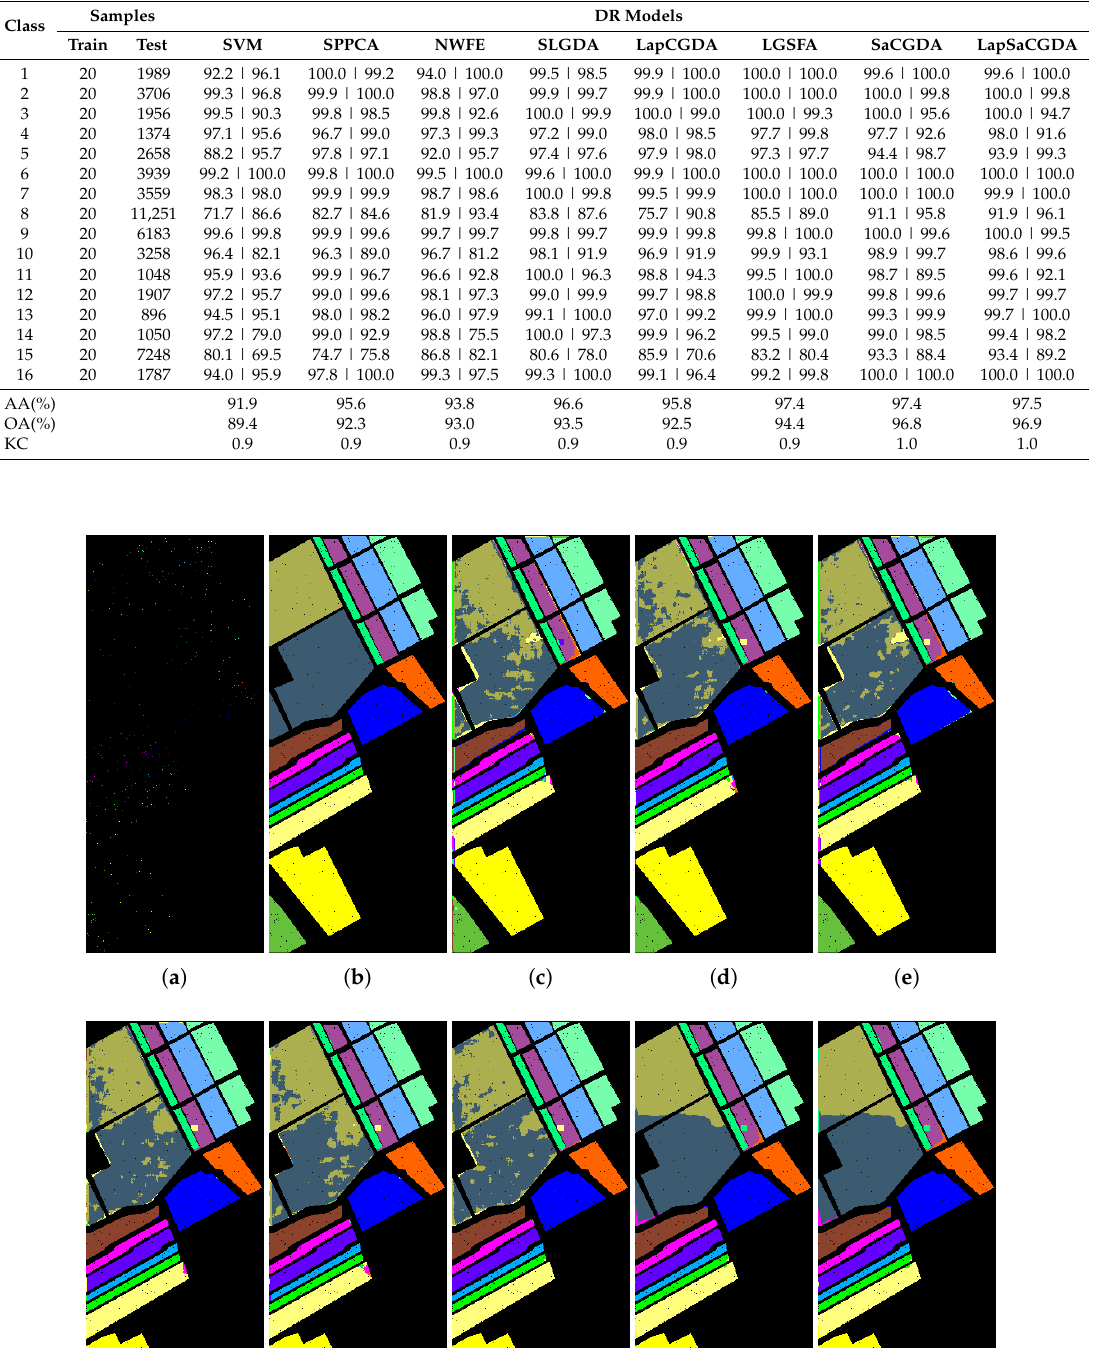
Table 6. Classification results of different DR methods based on SVM on the Salinas data (the TPR and FPR of each class are displayed in the left and right sides of the vertical line, respectively).